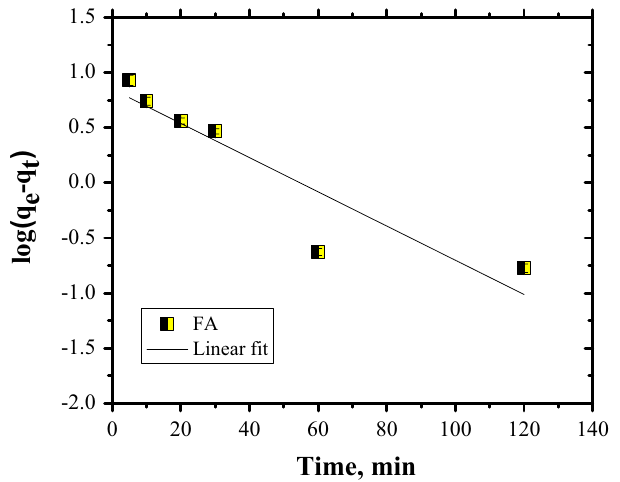
Figure 11. PFO kinetics of Congo Red dye adsorption.